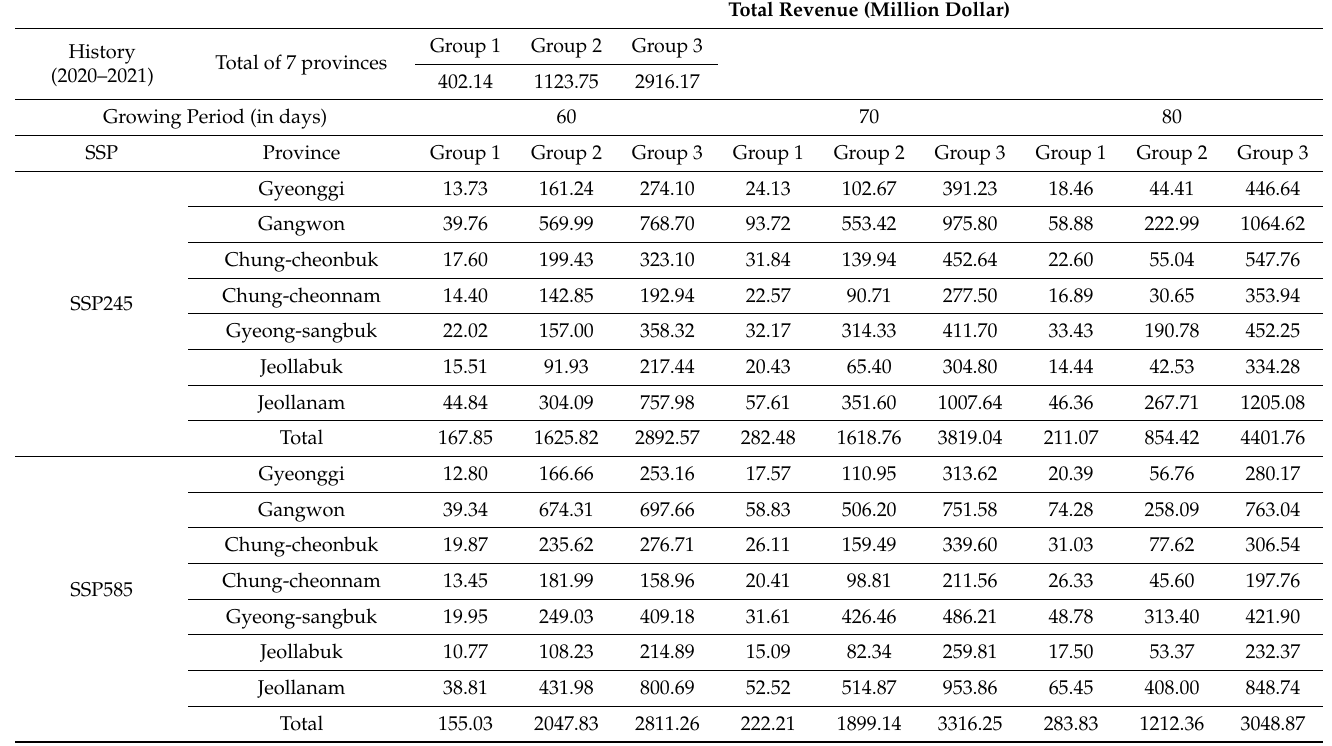
Table 8. Total revenue of Chinese cabbage (USD millions) in seven provinces in South Korea under two climate change pathways (SSP245 and SSP